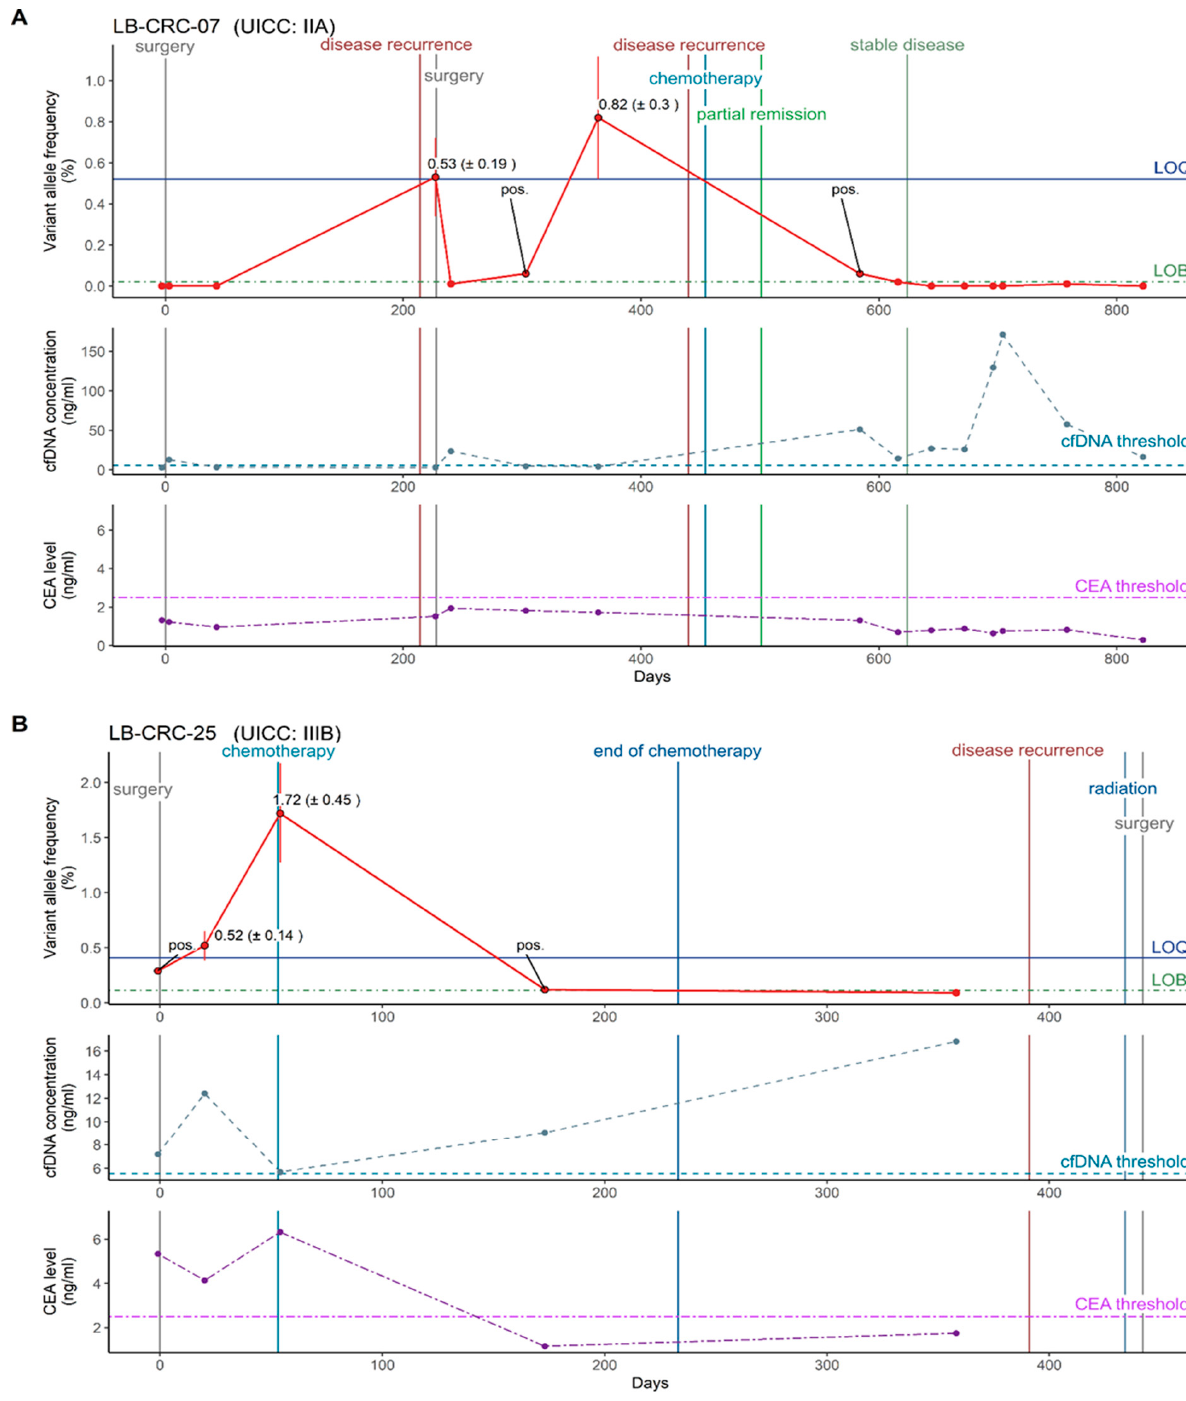
Figure 4. ctDNA (line 1), cfDNA (line 2) and CEA (line 3) analysis throughout the course of the disease in two CRC patients ( A ) LB-CRC-07 and ( B ) LB-CRC-25, with recurrence. These results indicate higher sensitivity of ctDNA compared to cfDNA and CEA for detection of MRD and